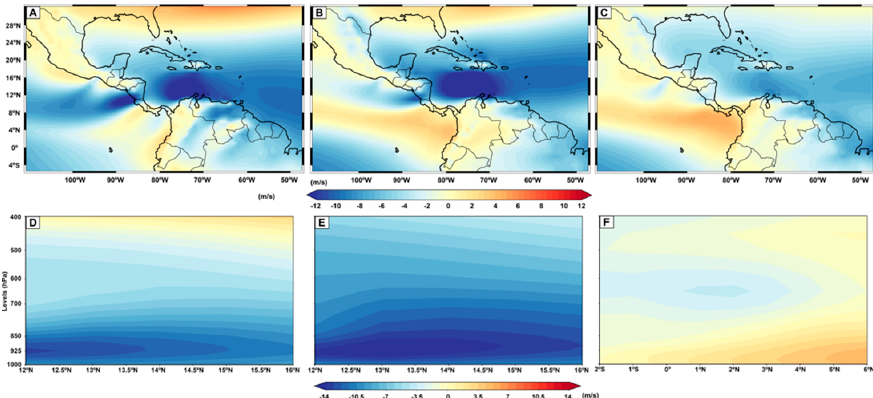
Figure 2. Mean zonal wind in 925 hPa for ( A ) January, ( B ) July, and ( C ) October. The mean annual vertical cross–section (1000–400 hPa) for 80° W–70° W from 12° N to 16° N for ( D ) January, ( E ) July, and ( F ) mean annual vertical cross–section (1000–400 hPa) for 90° W–80° W from 2° S–6° N for October. Data from ERA5.